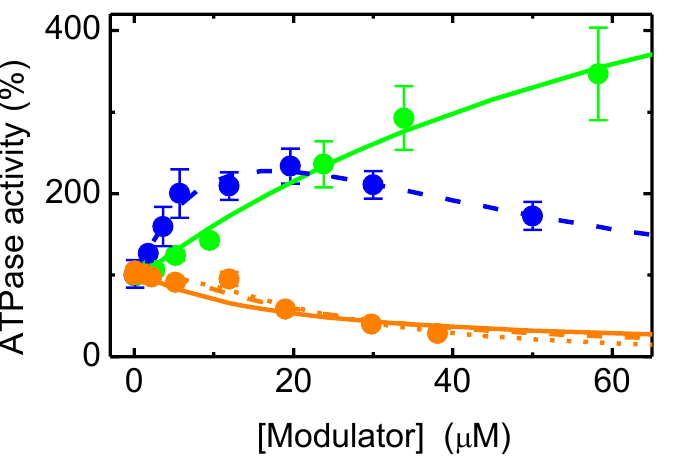
Figure 1. Effect of NBD–C4 ( • , – ), NBD–C8 ( • , - - -), and NBD–LysoMPE ( • , – , - - -, · · · ) on P–gp ATPase activity. The symbols represent the average of three to five independent experiments, and standard deviation is shown as error bars (sometimes smaller than the symbol size). The lines are the best fits of the usual formalism that considers activation and uncompetitive inhibition on P–gp’s ATPase activity depending on the concentration of the modulator (Equation (S1)). The continuous lines consider only activation (for NBD–C4) or only inhibition (for NBD–LysoMPE), while the dashed lines consider both activation and inhibition. For NBD–LysoMPE, two situations are shown: the best fit imposing K 1 ≤ K 2 (- - -) and no constraint ( · · · ). See Table S1 for the parameter values. The basal ATPase activity is taken as 100%.